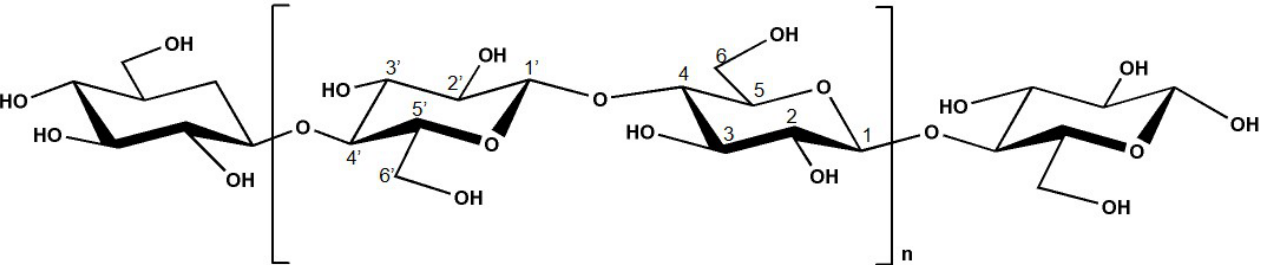
Figure 2. Chemical structure of cellulose.